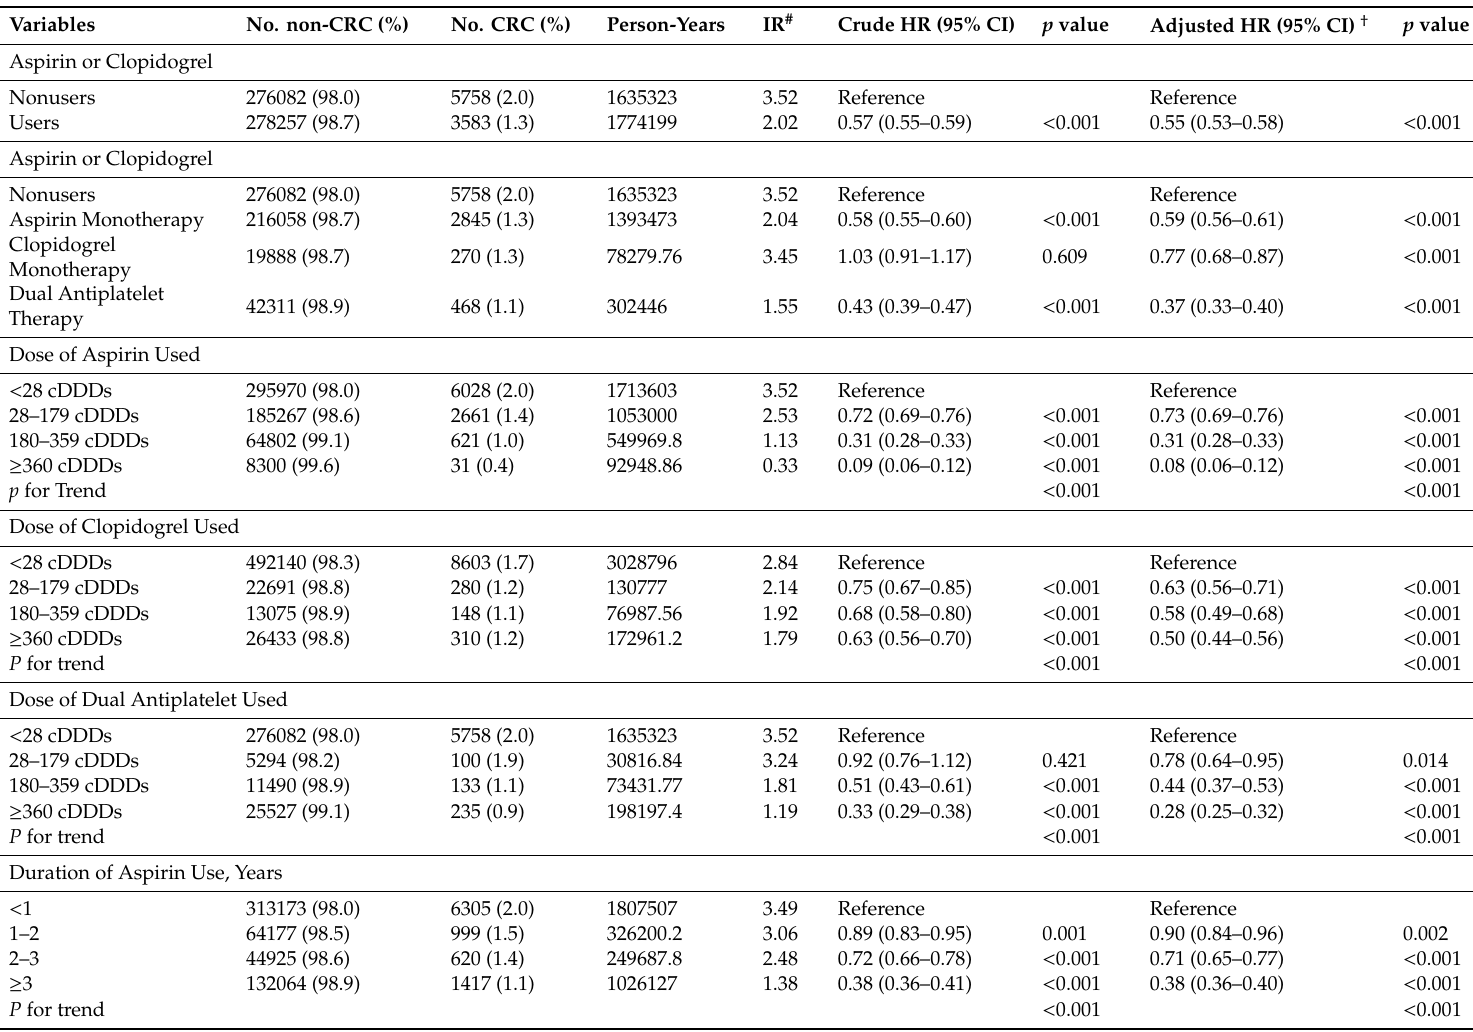
Table 2. Incidence rate and hazard ratio of colorectal cancer (CRC) in patients with Type 2 diabetes mellitus (T2DM) using or not aspirin and